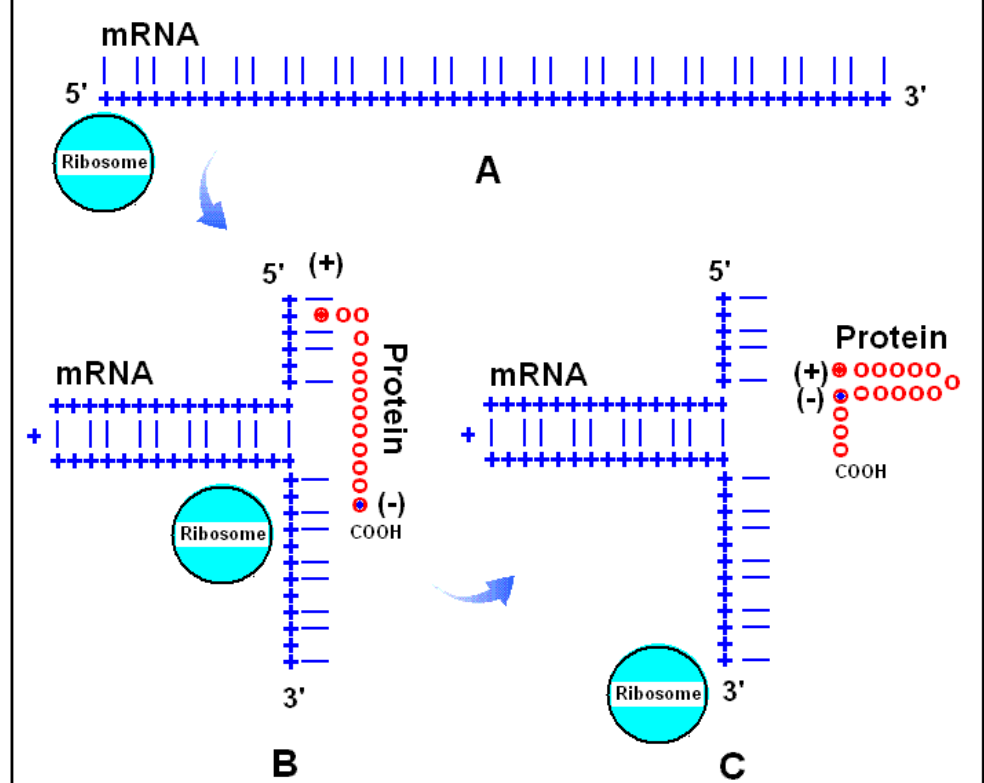
Figure 5. RNA assisted protein loop formation . Translation begins with the attachment of the 5' end of a mRNA to the ribosome (A). Ribonucleotides are indicated by blue + and the 1st and 3rd bases in the codons by blue lines, while the 2nd base positions are left empty. A positively charged amino acid [(+) and red dots], for example arginine, remains attached to its codon. The mRNA forms a loop because the 1st and 3rd bases are locally complementary to each other in reverse orientation (B). The growing protein is indicated by red circles (o). When translation proceeds to an amino acid with especially high affinity to the mRNA-attached arginine, for example a negatively charged Glu or Asp [(-) and blue dot], the charge attraction removes the Arg from its mRNA binding site and the entire protein is released from the mRNA and completes a protein loop (C). The protein continues to grow toward the direction of its carboxy terminal (COOH). (Figure is reproduced from